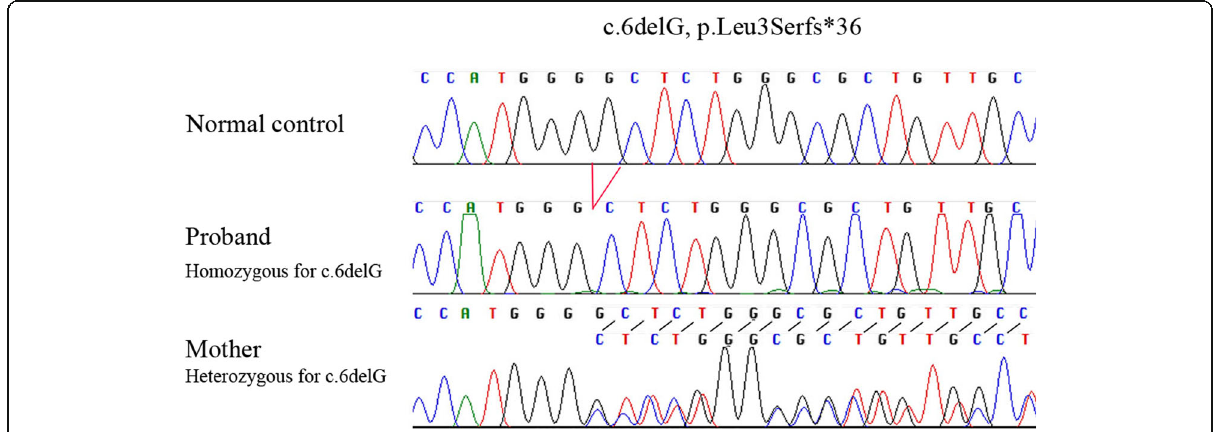
Fig. 3 Mutation analysis. Sanger sequencing shows that the proband is homozygous while his mother is heterozygous for the WNT1